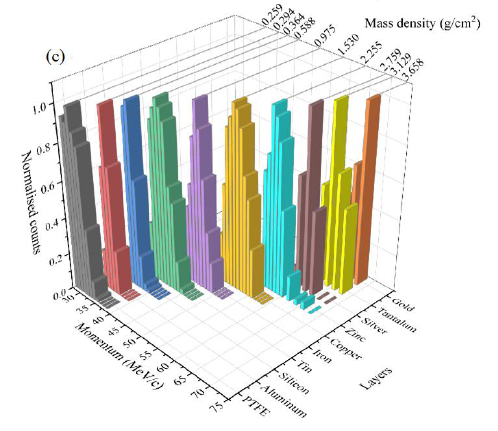
Figure 5. Muon depth distribution over a set of different momentum: ( a ) lower momentum; ( b ) higher momentum; ( c ) characteristic X-ray energy distribution. ( a , b ) The stopping depth was calculated by taking copper as reference material, taking into account a momentum spread of 4%. The expected locations of the sample material boundary in this reference scale are shown by the dotted vertical lines, while the accumulative thickness is reported on the top axis. For a more detailed survey on particle ranges in material, see Section 34 “Passage of particles through matter” (Figure 34.4) in [22]. ( c ) The 3D graph shows the distribution of the characteristic muonic X-ray intensity of the elements present in the different layers, with the penetration depth (in g/cm 2 ) reported on the top axis. The data and the figure were taken and adapted from Ref. [23]. 2.3. Muon Instrumentation Muonic X-ray instruments for cultural heritage experiments are currently installed at J-PARC and MuSIC (Japan) and ISIS (UK) muon facilities [24–26] and under devel- opment at PSI (Switzerland) [27] and TRIUMF (Canada). Generally, the instruments consist of several detectors placed around the sample position, as in Figure 6. In most cases, high purity germanium detectors are in place, but Si(Li) detectors can also be used. The latter, however, are limited to low energy measurements (up to 100 keV) and for measuring high-energy muonic X-rays, high-purity germanium detectors are a more convenient choice. Germanium detectors can cover a wide energy range, from a few keV